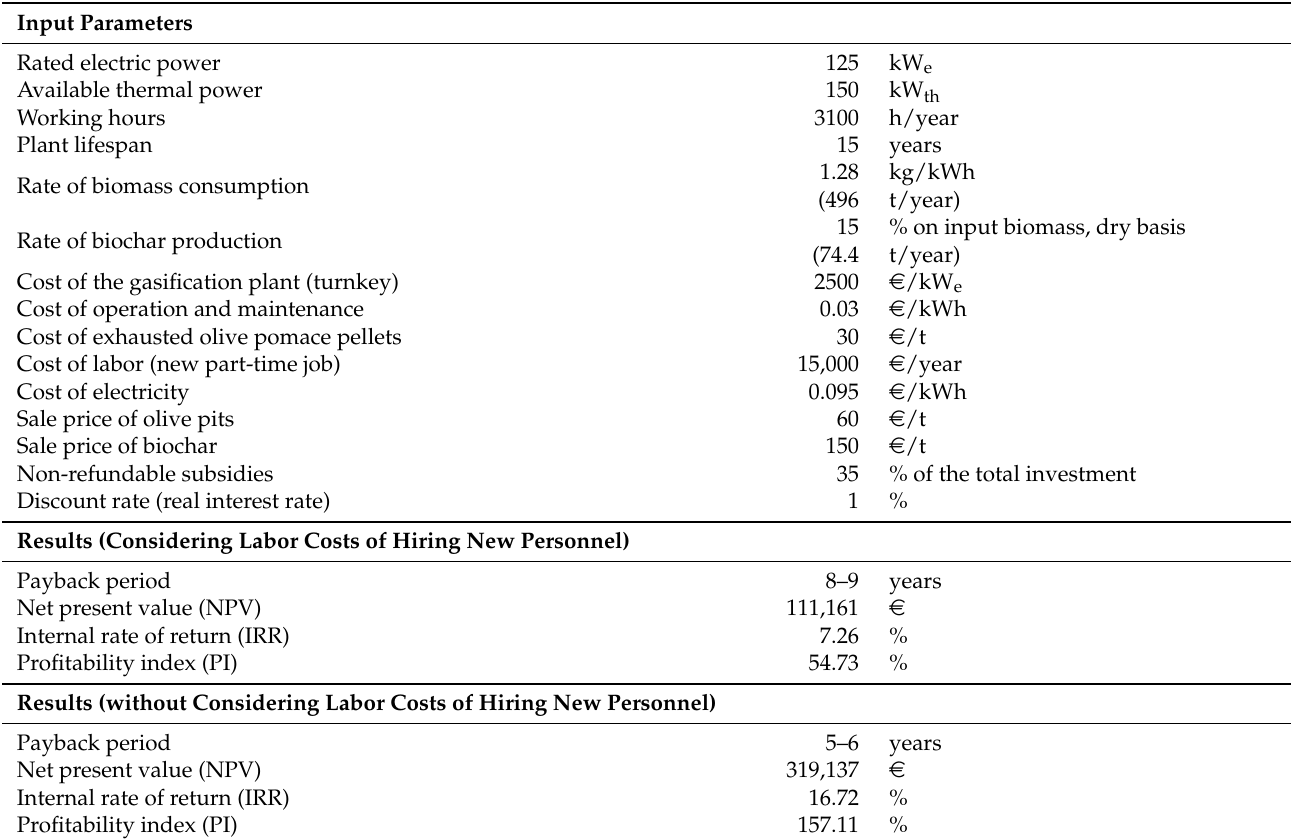
Table 10. Input parameters and results of the economic feasibility assessment of the gasification